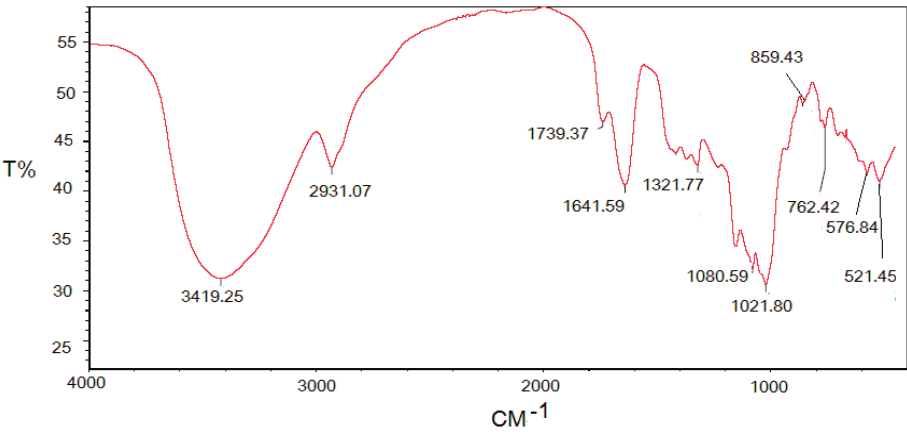
Figure 1. IR spectrum of the polysaccharide DOTP-80.